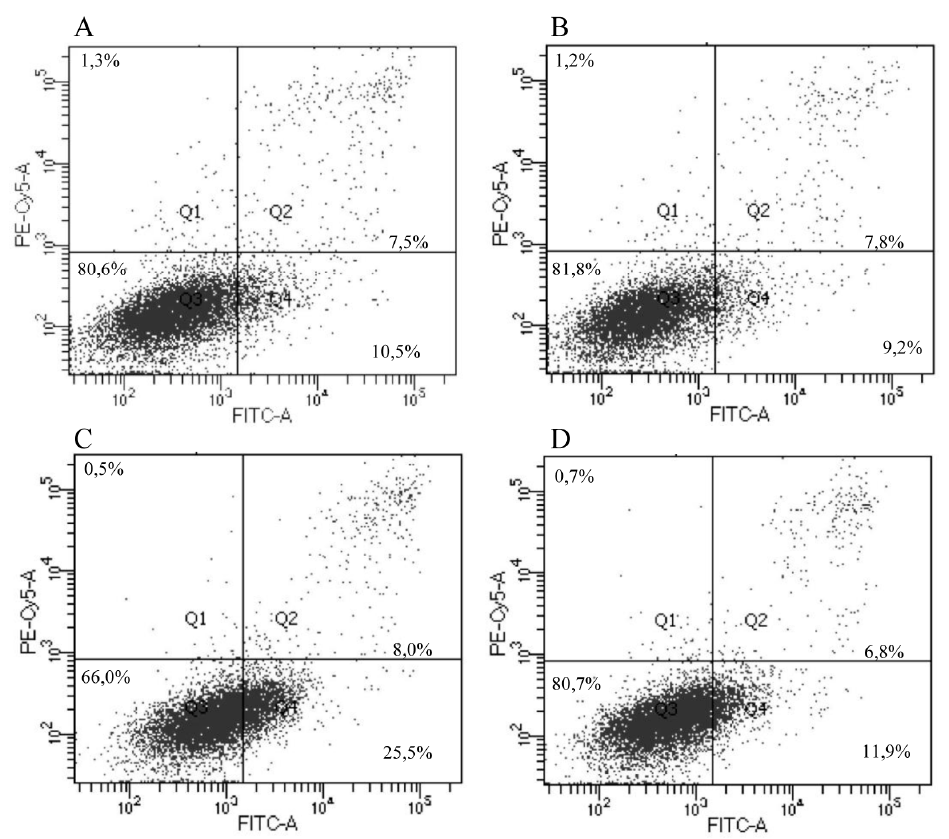
Figure 6. Impact of IrSPI on endothelial cell apoptosis. Viability and apoptosis were monitored by flow cytometry in human skin microvascular endothelial cell line (HSkMEC) endothelial cells after labeling with propidium iodide and Annexin V-FITC, respectively. Cells were incubated for 40 h in